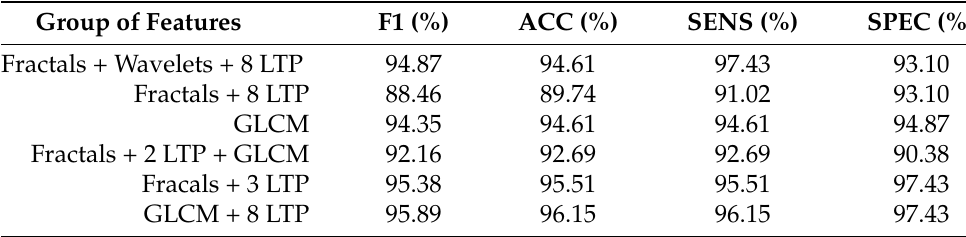
Table 6. Experiment 1—Final results using various performance